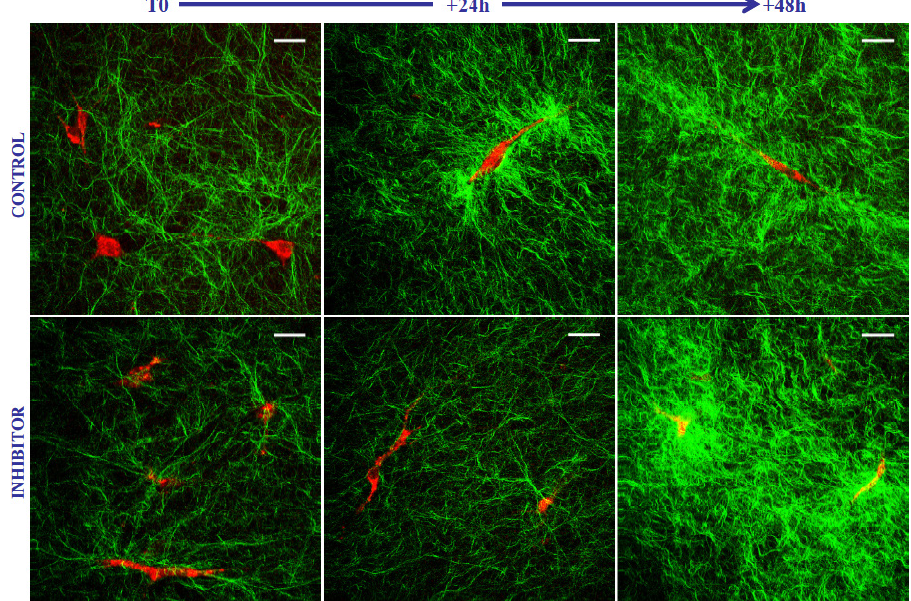
Fig. 2. Multiphoton imaging of collagen matrix remodeling induced by ¯broblast contraction. Combined 2PEF (red) and SHG (green) images of ¯broblasts within control and Y-27632 treated collagen gels. The images were acquired at T0-before samples contraction; T þ 24 h and T þ 48 h — 24 h and 48 h after free contraction of the samples. At T þ 24 h, the ¯broblast inhibitor was removed from the culture medium and replaced with a control culture medium in order to assess the reversibility of the inhibitor e®ect. Scale bar: 30 m. Excitation: 60 mW at 730 nm. Objective: 20 (cid:1) , 0.9 NA. Acquisition time: 6.9s/image of 681681 pixels. Reproduced with permission from Ref.